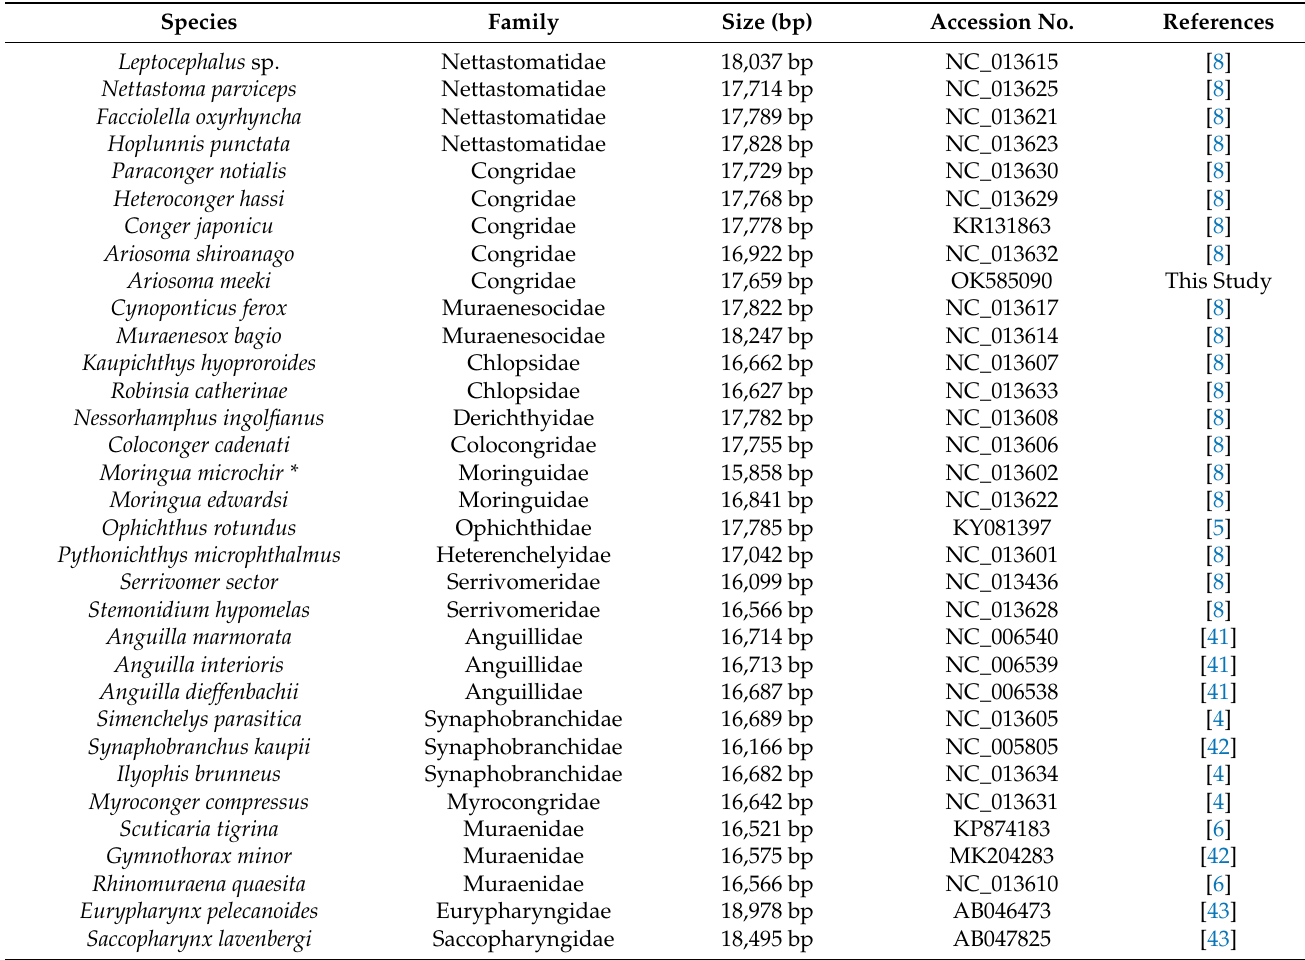
Table 1. List of the 31 Anguilliformes species and 2 outgroups used in this paper.